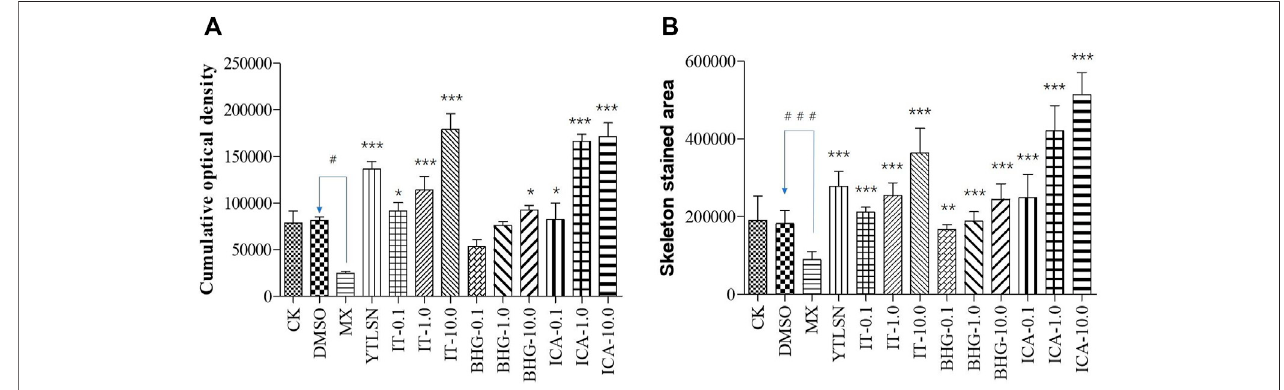
FIGURE 4 | The effect of ICA, IT, and BHG-I- I on mineralization in zebra fi sh larvae ( n = 15). (A) Calculation of cumulative optical density. (B) Calculation of mineralized area. CK, blank E3 medium; DMSO, 0.5% DMSO; MX, 25 μ M PNSL; YTLSN, 15 μ M disodium ethydronate + 25 μ M PNSL; ICA, 0.1, 1.0 or 10.0 μ M